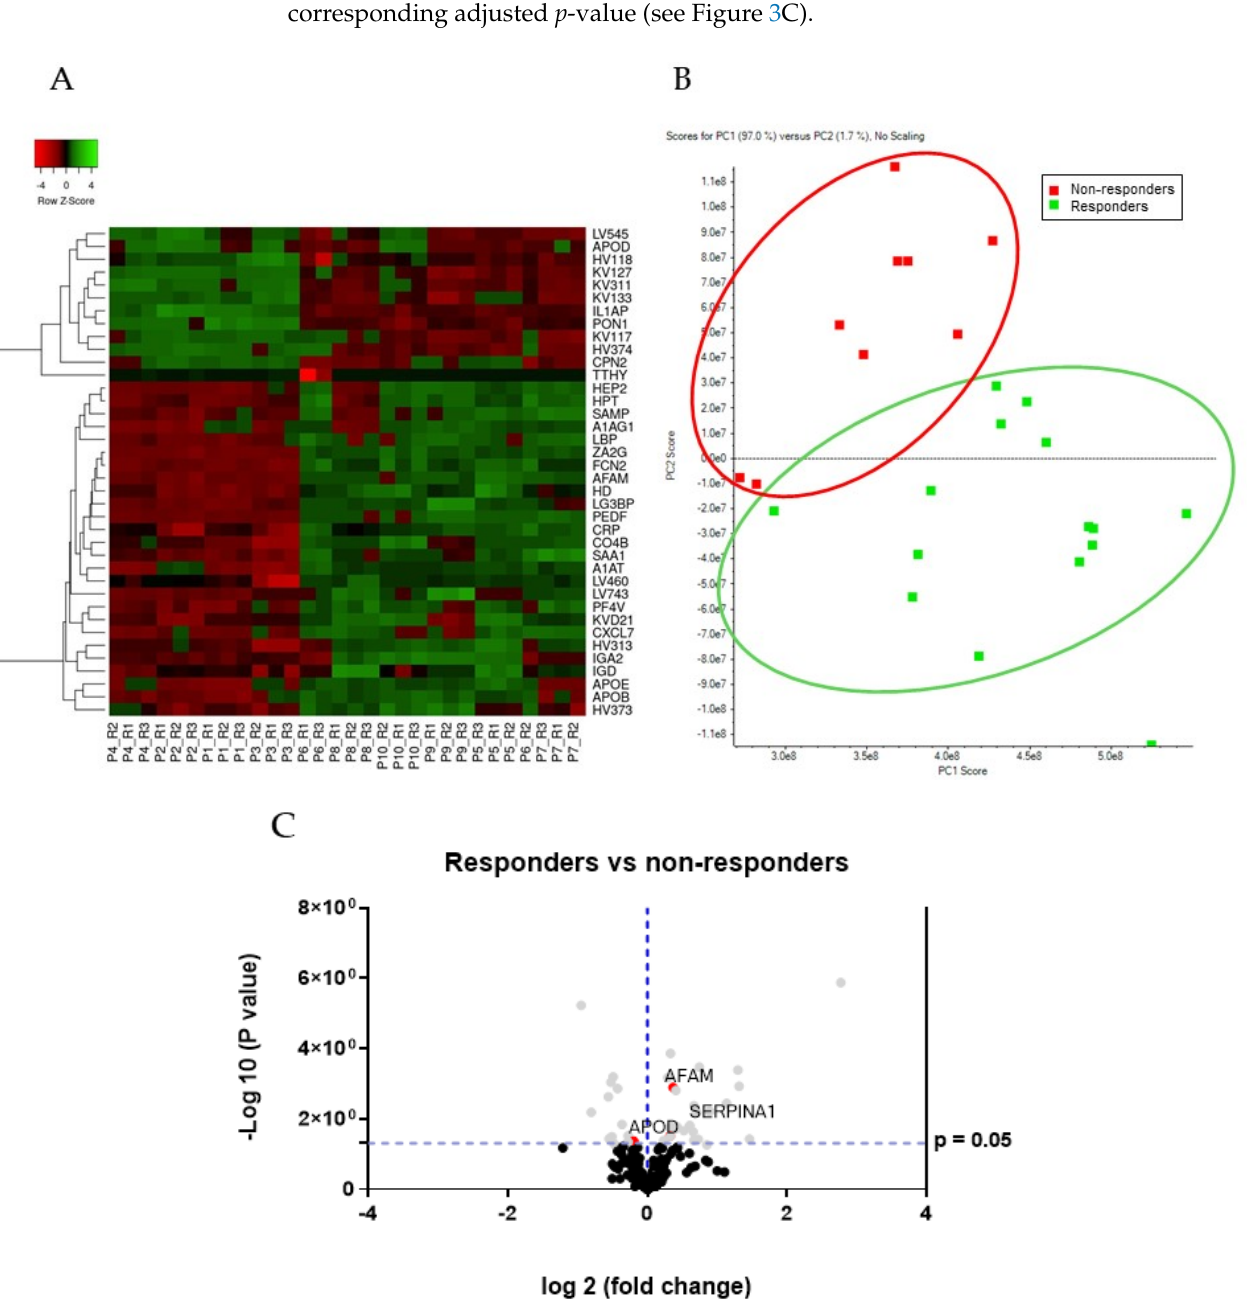
Figure 3. Unsupervised analysis of differentially expressed proteins in serum from responders vs. non-responders to NAC by SWATH-MS. ( A ) Heat map showing hierarchical clustering between responders and non-responders to NAC using the top 38 differentially expressed proteins. Protein expression values were z-score normalized prior to clustering. ( B ) PCA analysis showing the separation of samples from responders (green) and non-responders (red) to NAC. ( C ) Volcano diagram resulting from the statistical analysis of the 306 proteins (library proteins) quantified among responder and non-responder groups. Proteins are separated according to the log2 of the FCh ( x -axis) and the − log10 of the p -values based on a two-tailed t-test ( y ‐ axis). To interpret global changes in the serum proteome associated with response/re ‐ sistance to NAC, the 38 proteins whose levels were significantly different between re ‐ sponder and non ‐ responder patients following method 1 were analyzed using the